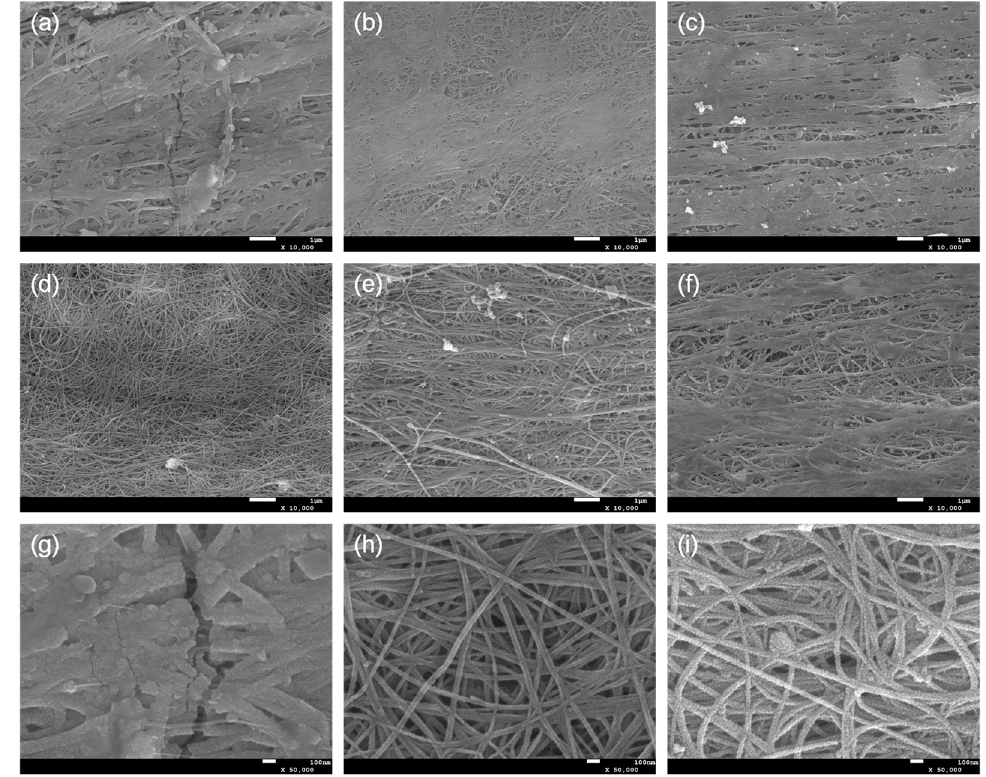
Figure 3. SEM images of ( a ) 0SC, ( b ) 0.025SC, ( c ) 0.05SC, ( d ) 0.1SC, ( e ) 0.2SC, and ( f ) 0.3SC. Magnified SEM images of ( g ) 0SC, ( h ) 0.1SC, and ( i ) 0.2SC.